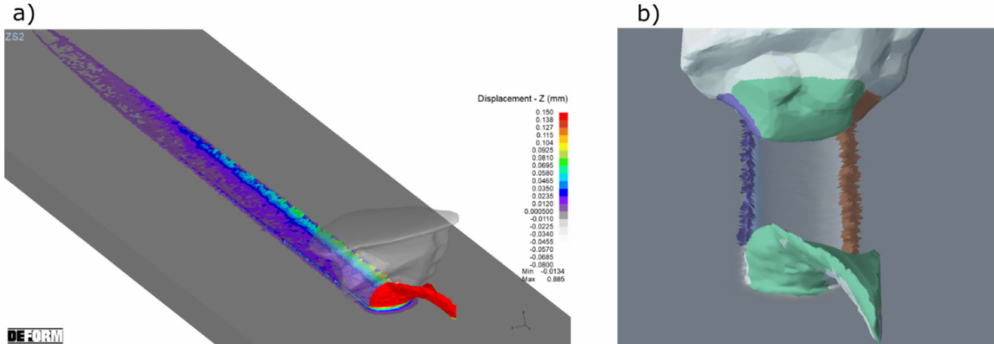
Figure 14. The results of a computer simulation of the cutting process with ZS2 grain ( a ) and the colored areas which caused the plastic flows of the processed material ( b